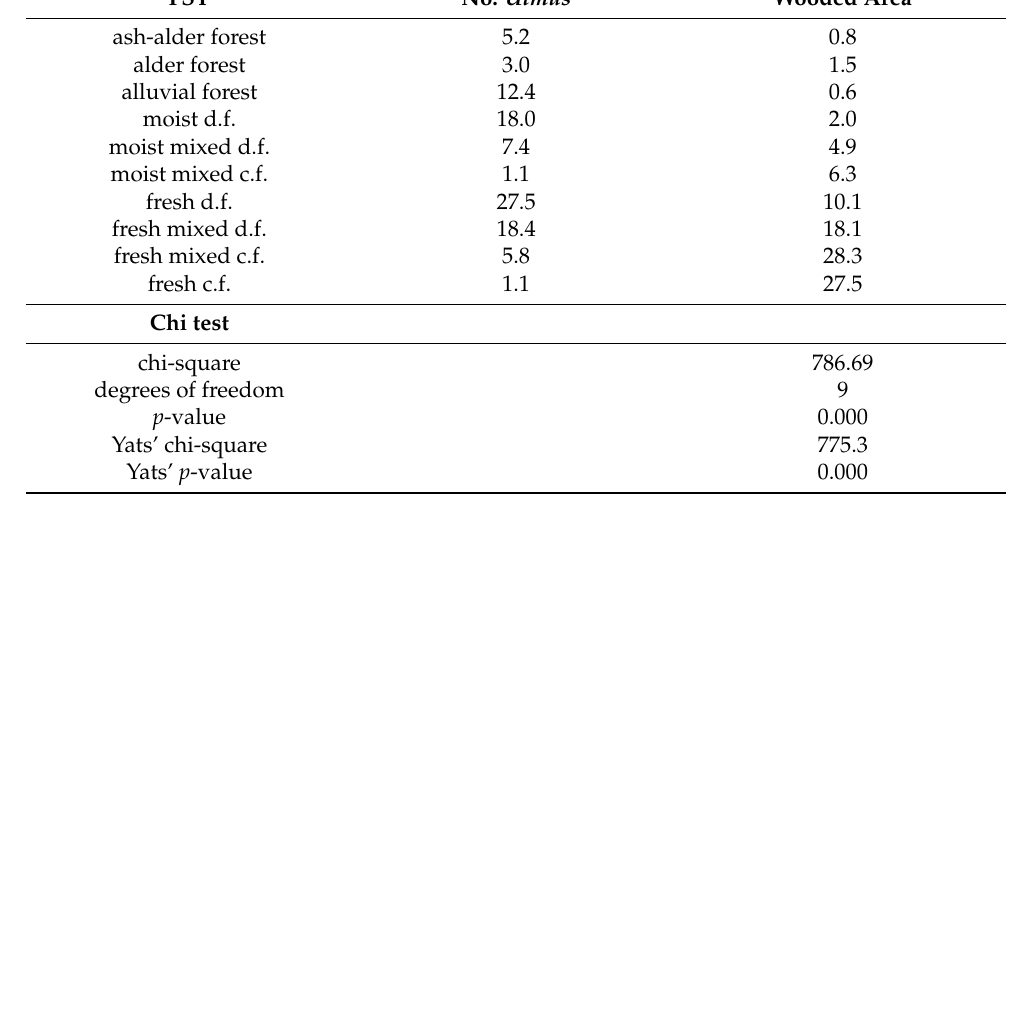
Table 3. Percentage distributions of the number of forest plots with elms (No. Ulmus ) and total wooded area in Poland in forest sites of various types (FST). c.f.—coniferous forest, d.f.—deciduous forest. FST No. Ulmus Wooded Area ash-alder forest 5.2 alder forest alluvial forest moist